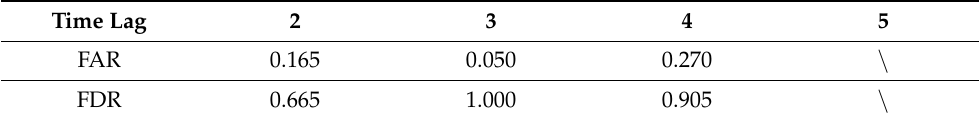
Table 3. FAR and FDR under different time lag.